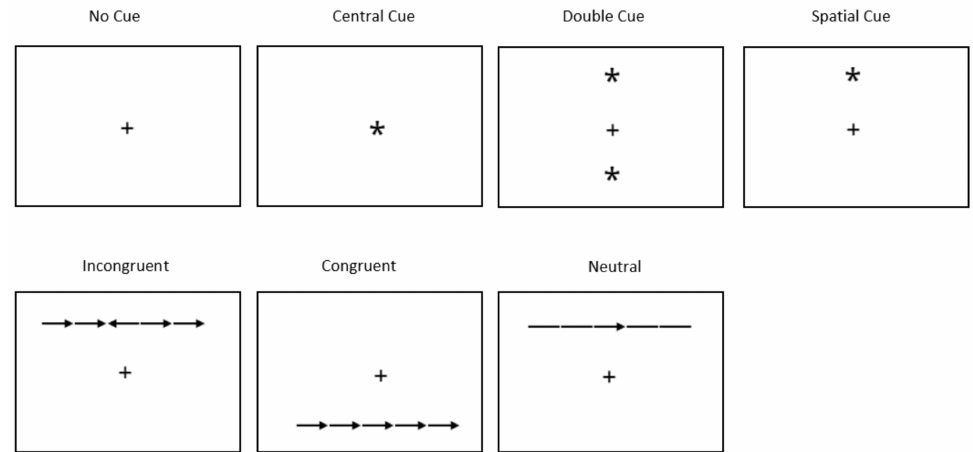
Figure 2. Example stimuli from the ANT. The top row shows the four warning cue types and the bottom row shows the three flanker type